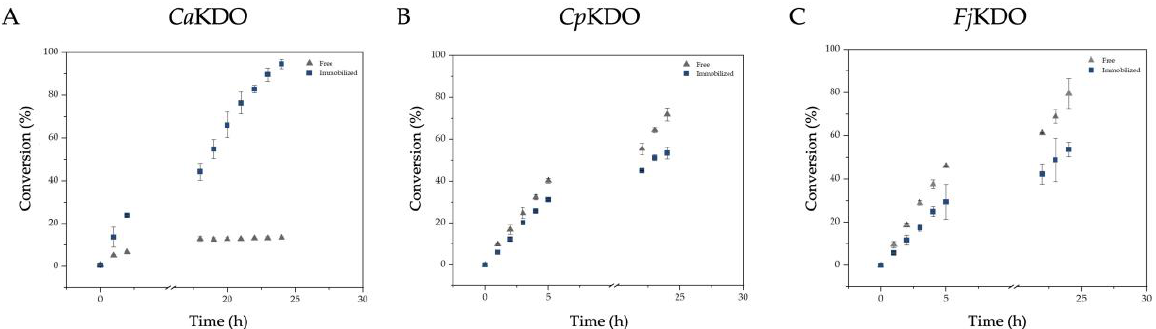
Figure 3. Enzyme stabilities of HaloTag ® -immobilized versus free (with His-Tag) KDO variants under the reaction conditions. ( A ) Ca KDO-HaloTag ® vs free Ca KDO ( B ) Cp KDO-HaloTag ® vs free Cp KDO ( C ) Fj KDO-HaloTag ® vs free Fj KDO. Reaction conditions: 200 mM HEPES, pH 7.5, and 0.5 mg mL −1 catalyst, 100 mM L-lysine, 150 mM α -KG, 2.5 mM L-ascorbic acid, and 1 mM (NH 4 ) 2 Fe(SO 4 ) 2 for 24 h at 25 °C in an overhead shaker. Reaction volume 1 mL. For further information, see Section 3.3. Error bars are a result of the reaction carried out with two independently immobilized batches.